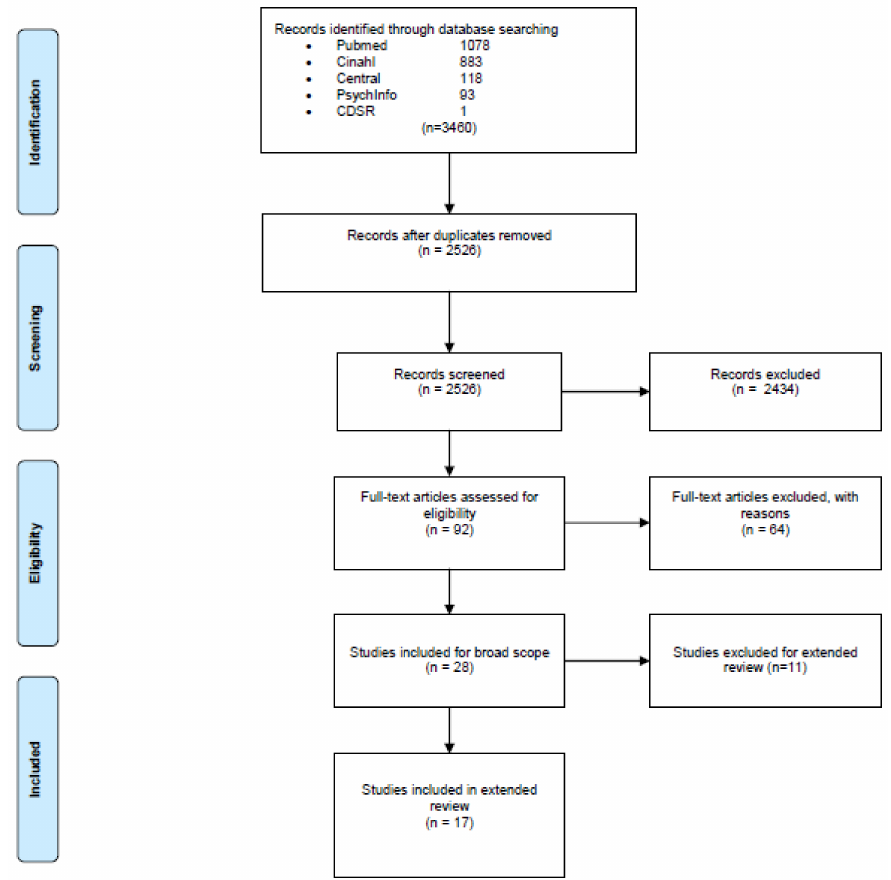
Figure 1. Prisma flowchart of literature search